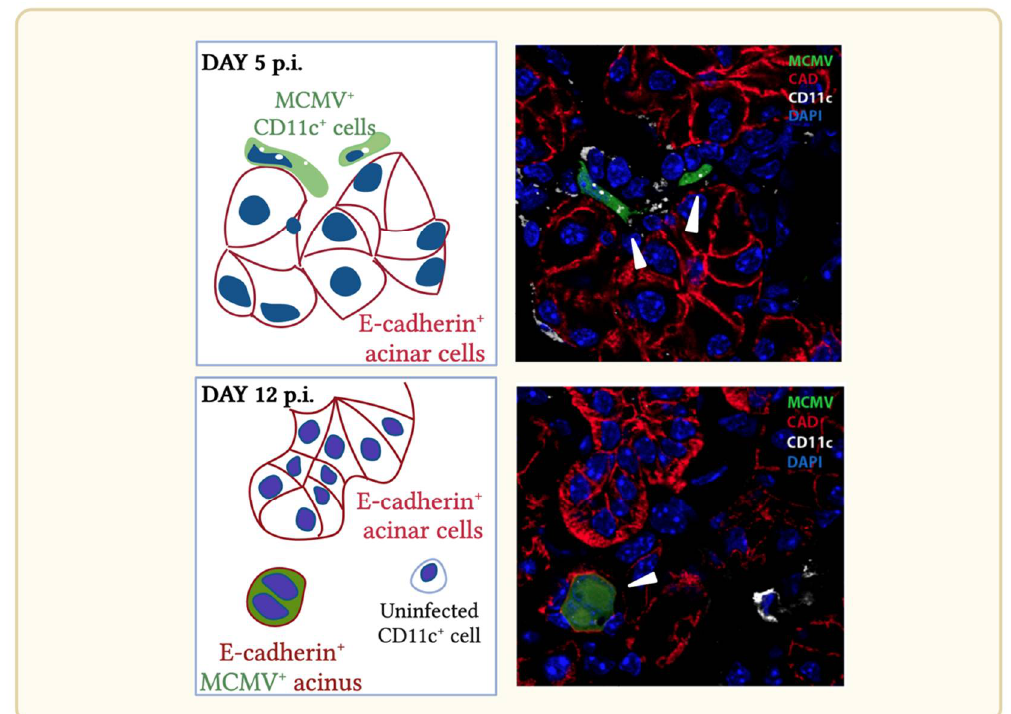
Figure 4. Schematic and corresponding immuno-histochemistry of cells infected in the salivary gland during acute (day 5) and persistent (day 12) MCMV infection. Mice infected intranasally with EGFP-tagged MCMV exhibit infected cells at day 5 p.i. and display characteristic punctate CD11c expression. Infected cells lie interposed between E-cadherin + salivary gland acinar cells. By day 12 p.i. wild type MCMV infection is found predominantly in CD11c - /E-cadherin + acinar cells. Infected cells indicated by